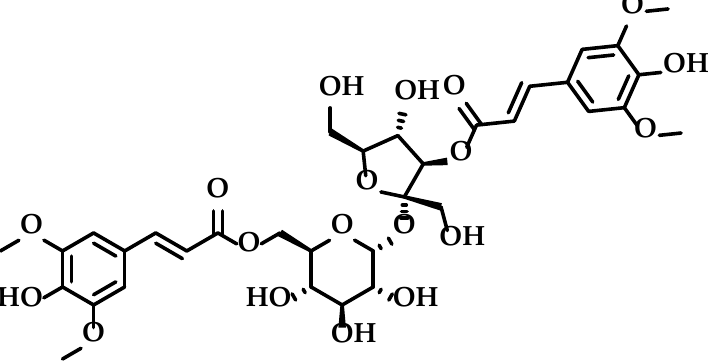
Figure 1. Structure of 3,6′ -disinapoyl sucrose.